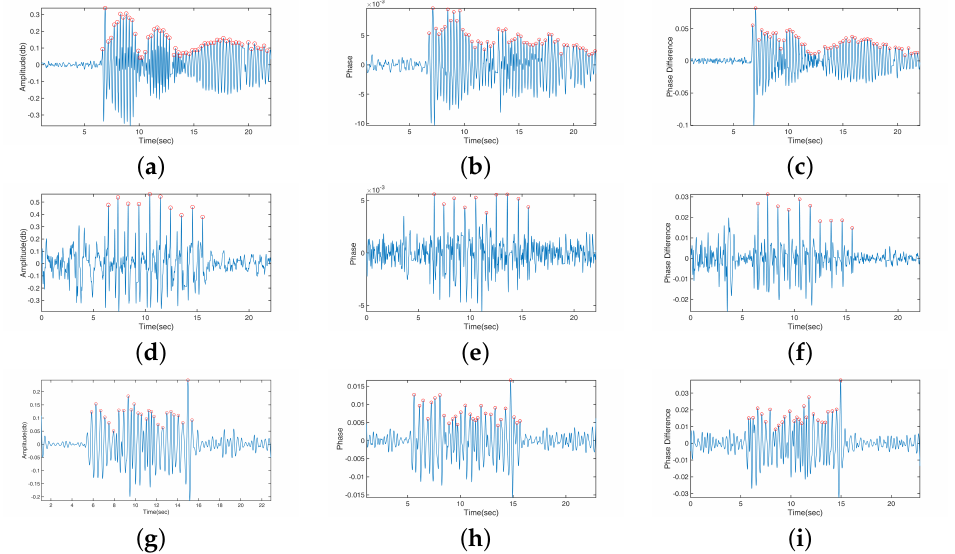
Figure 8. The processed CSI data of target motion from the three types of basic signals. The red circles indicate peaks in the data identified by our algorithm and are used to count the number of movements. ( a ) Steel ruler vibration—amplitude. ( b ) Steel ruler vibration—phase. ( c ) Steel ruler vibration—phase difference. ( d ) Finger tapping—amplitude. ( e ) Finger tapping—phase. ( f ) Finger tapping—phase difference. ( g ) Resting tremor—amplitude. ( h ) Resting tremor—phase. ( i ) Resting tremor—phase